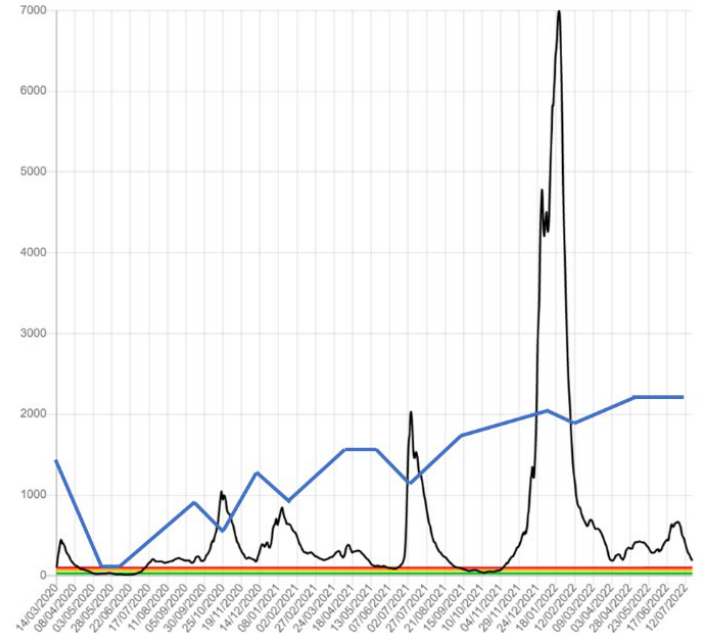
Figure 1. Weekly confirmed cases of COVID-19 in our healthcare area in Catalonia (Spain) from March 2020 to June 2022; the image also shows both the percentage of patients with COVID-19 and attendance at DR screening. Blue line = weekly confirmed cases of COVID-19 in our HCA from 1 March 2020 to 30 June 2022. Black line = weekly attendance at DR screening from 1 March 2020 to 30 June 2022 in our HCA.